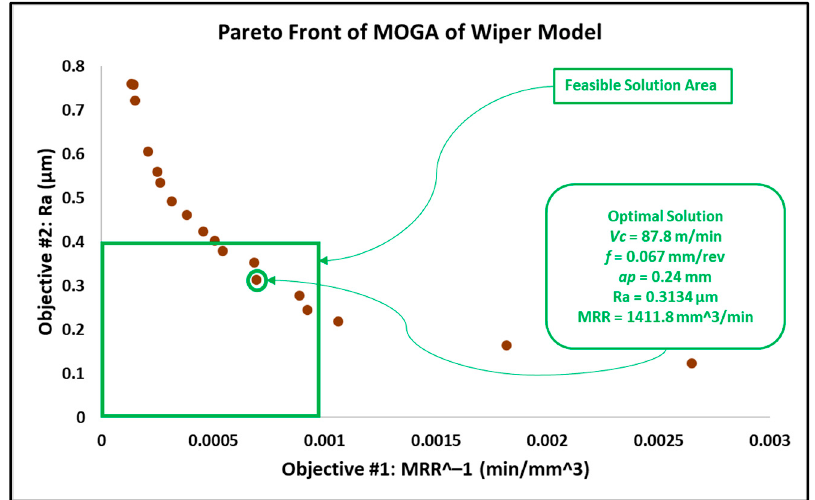
Figure 8. Pareto front plot of MOGA solution of the wiper model.